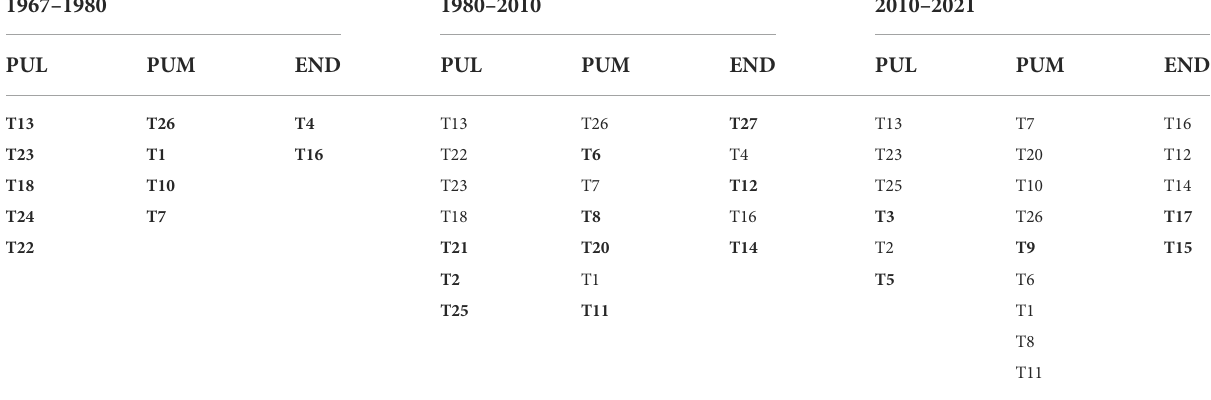
TABLE 4 The annual distribution results of topics based on